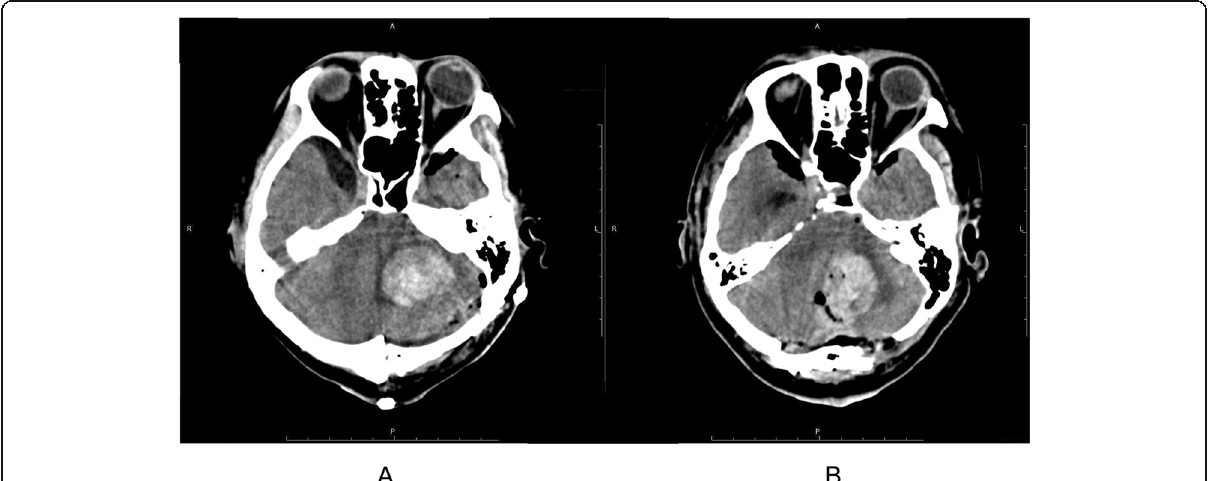
Fig. 1 Postoperative intracranial hematoma. Postoperative brain computed tomography showing intracranial hematoma. Hematoma in the left cerebellopontine angle in case 1 ( a ) and case 2 ( b ) was detected by postoperative bran computed tomography examined after the onset of bradycardia in the